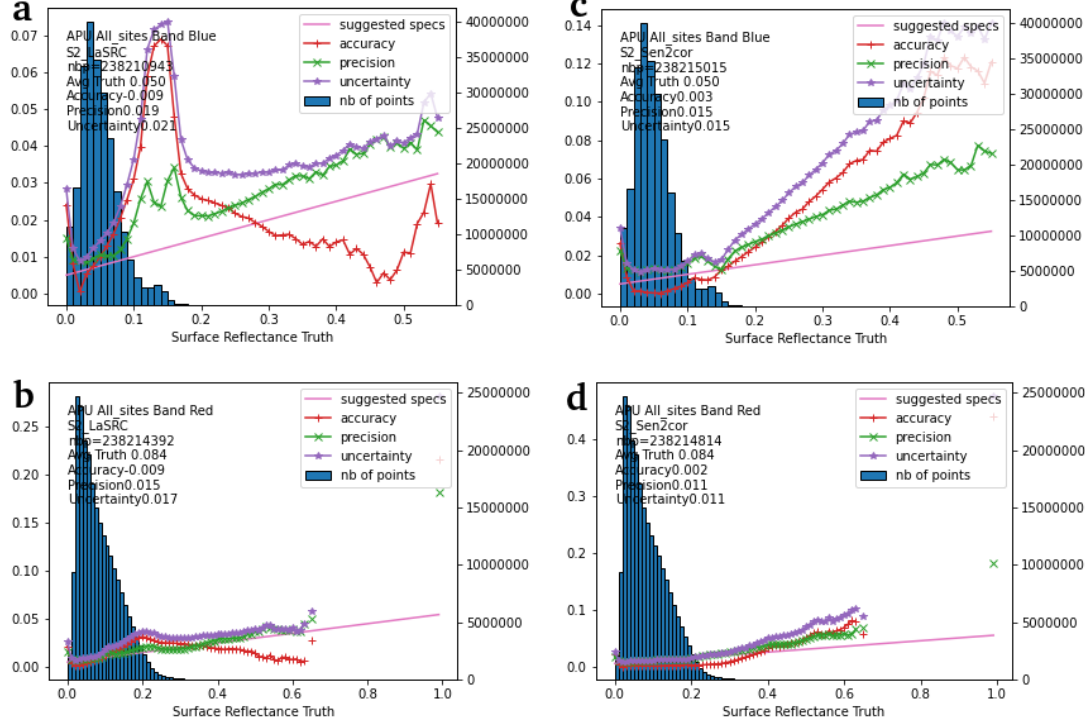
Figure 6. Scatter plots of Sentinel-2/MSI atmospherically corrected images containing accuracy (red line), precision (green line), and uncertainty (blue line) as computed in bins (blue bars) where the magenta line represents the theoretical SR reference for Sentinel SR (0 . 005 + 0 . 05 ˙ ρ ) . (a): Band 2 (Blue) corrected with LaSRC; (b) Band 4 (Red) corrected with LaSRC; (c): Band 2 (Blue) corrected with Sen2cor; (d) Band 4 (Red) corrected with